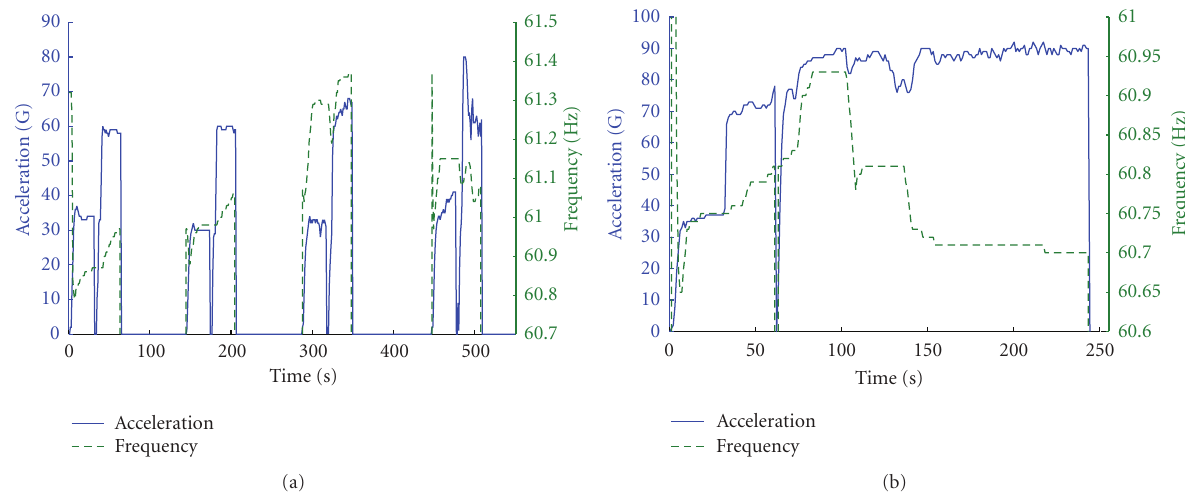
Figure 1: Traces from the Resodyn mixer: (a) acceleration and frequency of consecutive multiple mixing cycles; (b) acceleration and frequency of single mixing cycle of near constant intensity.